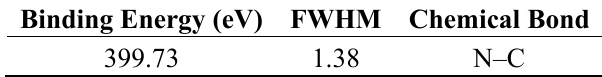
Table 2. The binding energy, FWHM and chemical bond corresponding to the N1s peak value of